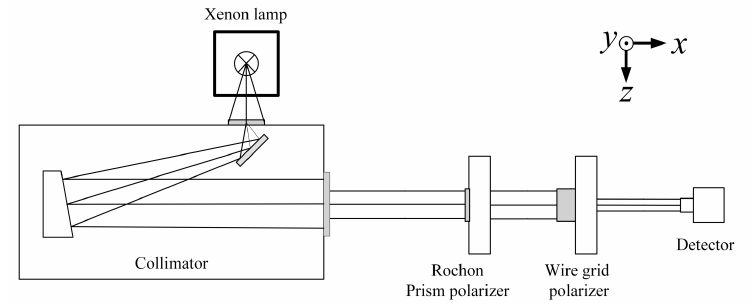
Figure 14. Wire grid transmission ratio test setup diagram.